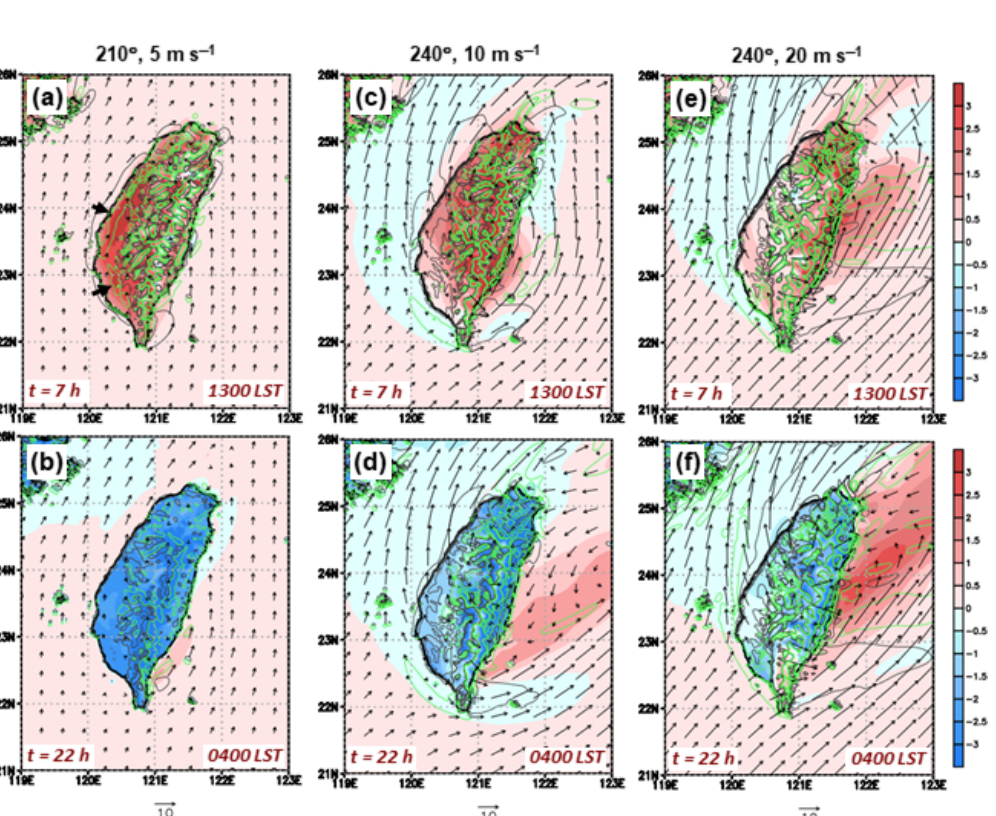
Figure 8. Surface wind vectors (ms − 1 , at 10m height, reference length at bottom), horizontal convergence/divergence (10 − 5 s − 1 , green/gray contours, at ± 5 and ± 30 × 10 − 5 s − 1 ), and surface air temperature ( ◦ C, at 1.5m height) difference (color, scale to the right) from 08:00LST (t = 2h) to (a) 13:00LST ( t = 7h) and (b) 04:00LST ( t = 22h) of the first cycle for the case of 5ms − 1 and 210 ◦ . (c–f) Same as in (a,b) except for the case of (c,d) 10ms − 1 and 240 ◦ and (e,f) 20ms − 1 and 240 ◦ . The arrows in (a) mark the convergence associated with sea